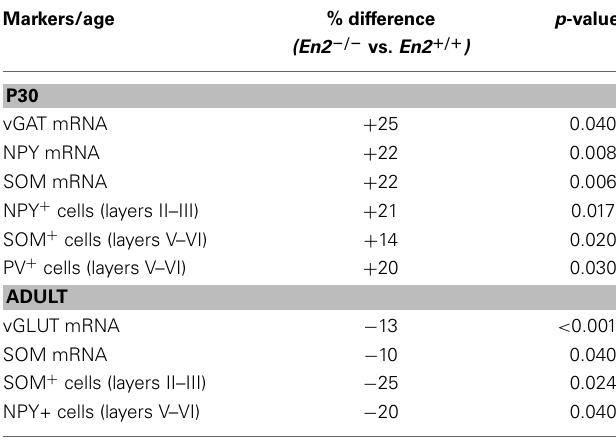
Table 2 | Expression of glutamatergic and GABAergic markers in the visual cortex: significant differences between En2 − / − and En2 + / +